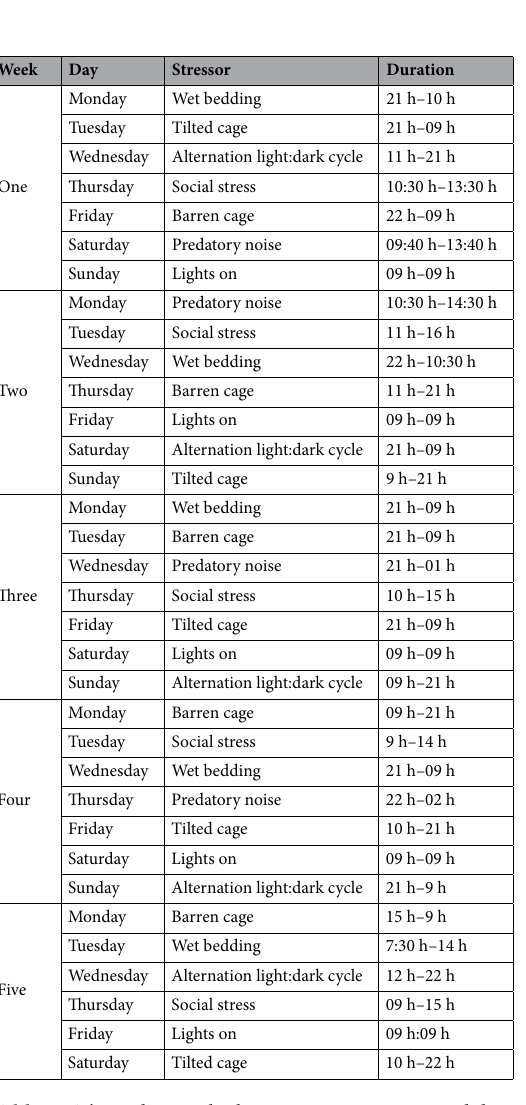
Table 3. The order in which stressors were presented during the